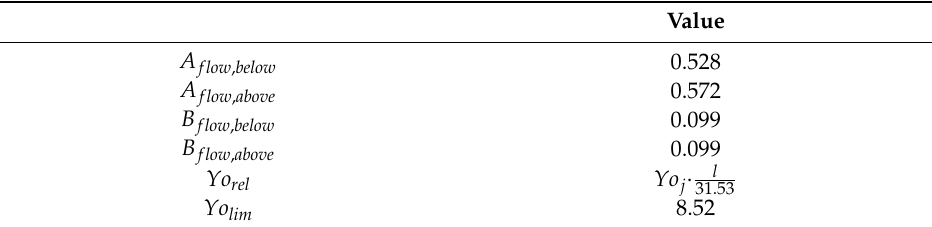
Table 4. Adjustment factors for the Rankine oval for